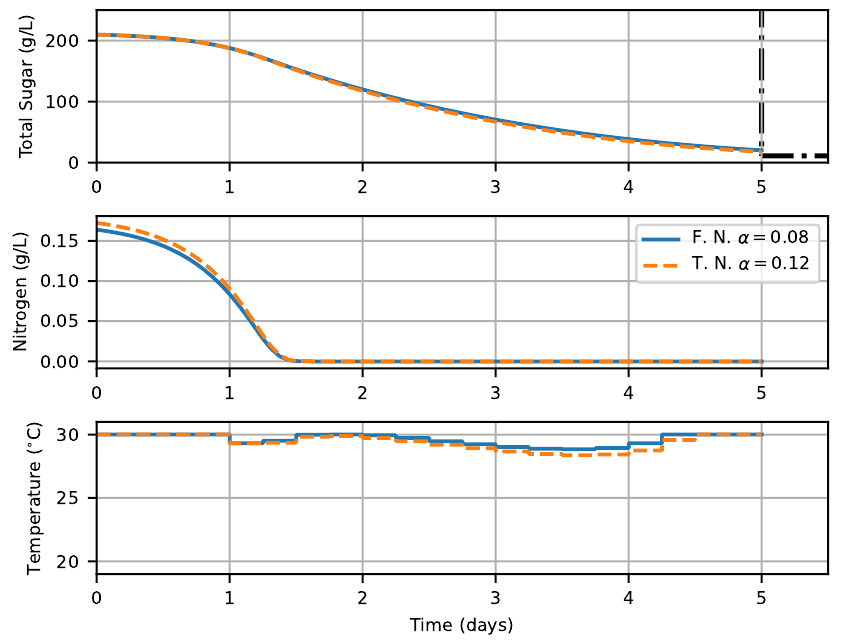
Figure 6. Comparison of the chosen optimal control strategies. Black line in total sugar graph corresponds to the desired digging-out